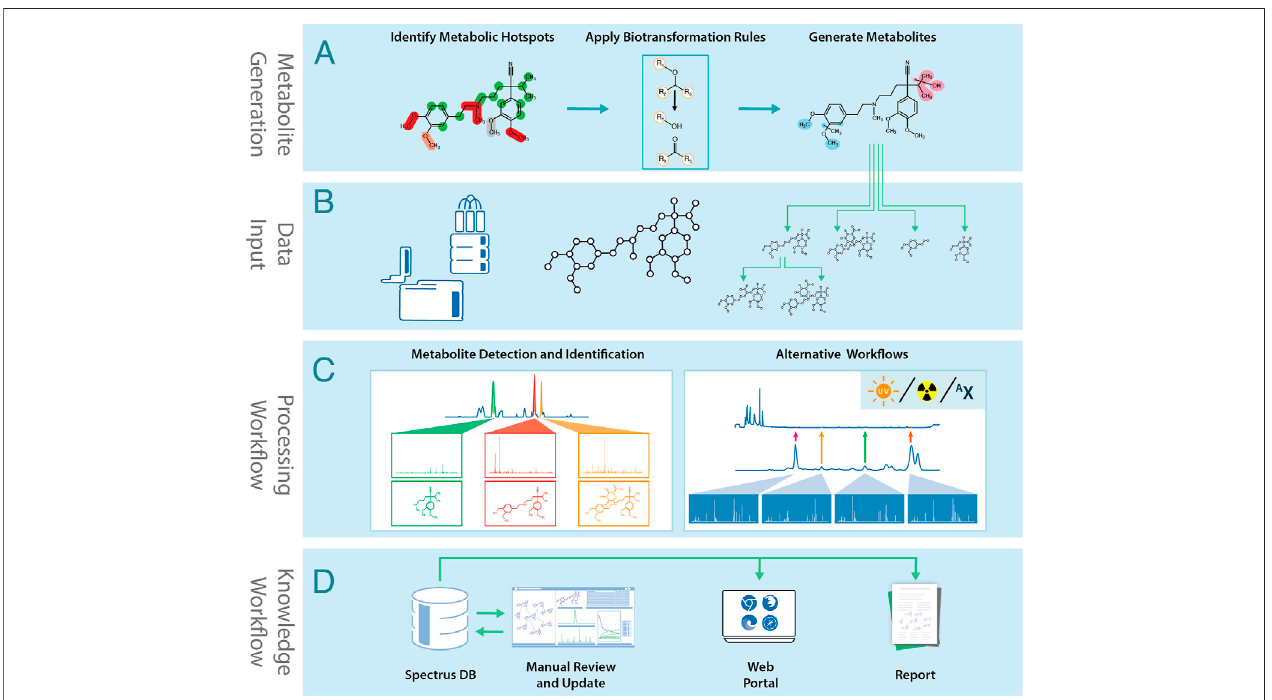
FIGURE 1 | The MetaSense metabolite generation and identi fi cation process: (A) Metabolites are generated using structural information and biotransformation rules. (B) Dataacquiredbyanalyticalinstrumentsiscombined withthemolecular structure and biotransformation predictions. (C) Analyticaldataisprocessed toidentify metabolites. (D) ProcesseddataisstoredinSpectrusDBdatabase.Datacanbemanuallyreviewedandprocessed, accessed via softwaretools, orbeused togenerate